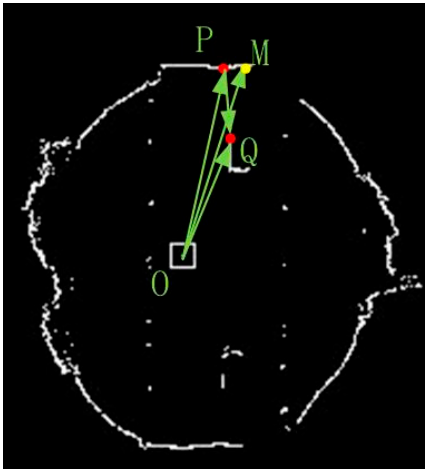
Figure 9. Schematic diagram for the influence of the obstacle on its tangential neighboring point.